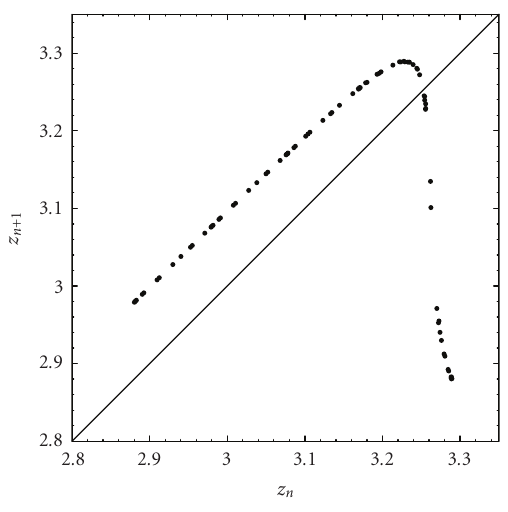
Figure 2.19. The iterated map for I = 3 . 25, r = 0 . 005, and s = 4 . 0.